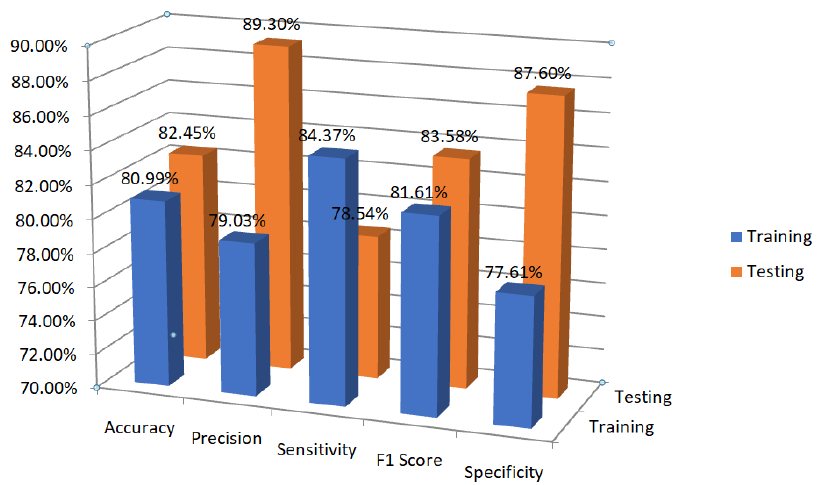
Figure 6. Evaluation metrics chart for training and testing data using GRU-SVM.